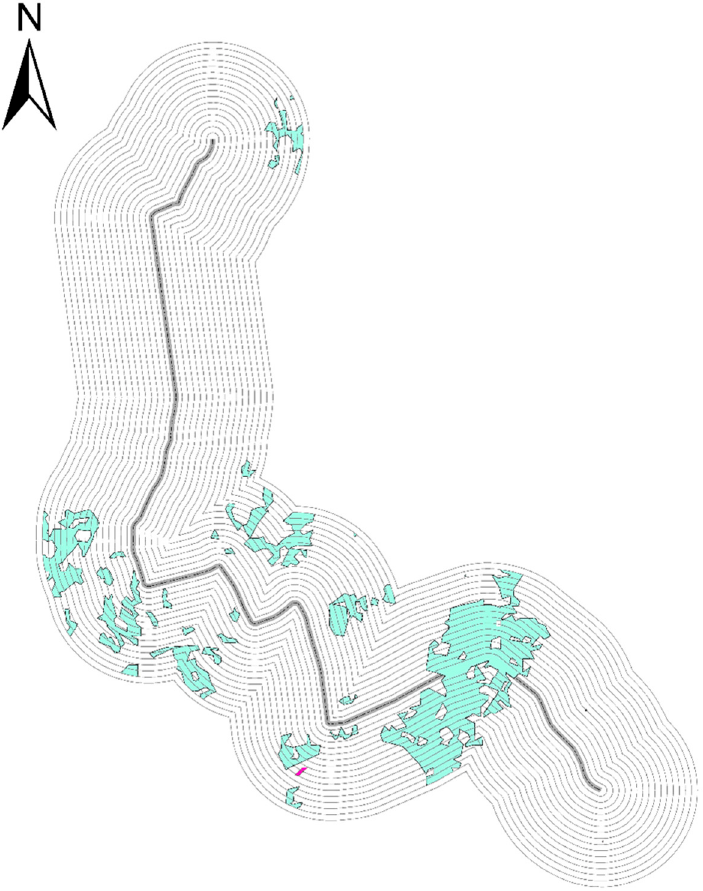
Figure 4. LUC maps associated with the LRT line from 1995 to 2000. Different rings show the buffer zone from the LRT with a 0.2 km zone.